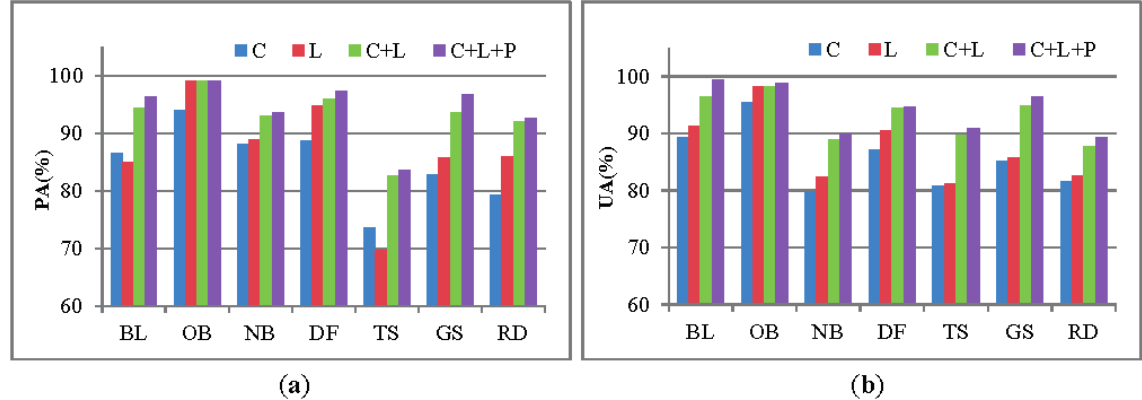
Figure 8. PA and UA histogram of Multi-Frequency